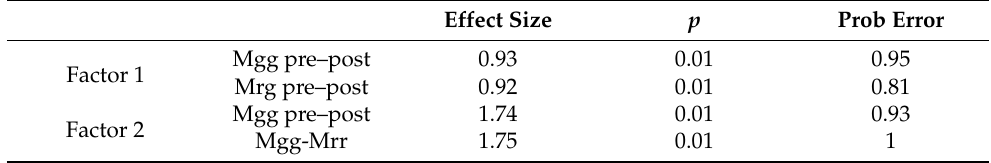
Table 5. Effect size and error